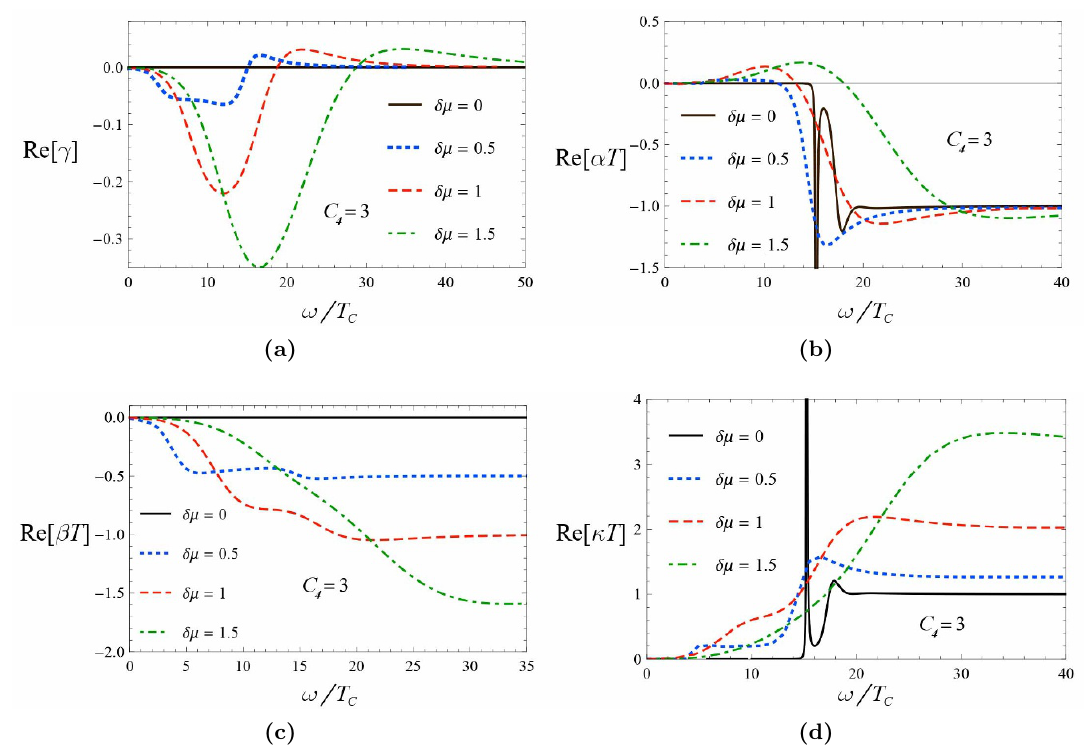
Figure 10. The real part of mixed, thermo-electric, thermo-spin, and thermal conductivities ((cid:12)gures (a), (b), (c), and (d)) in terms of !=T c for (cid:14)(cid:22) = 0 ; 0 : 5 ; 1 ; 1 : 5 (solid curve, dotted curve, dashed curve, dot-dashed curve) and function F ( ) = 2 + 3 4 . We have considered the non- vanishing C 4 to highlight the